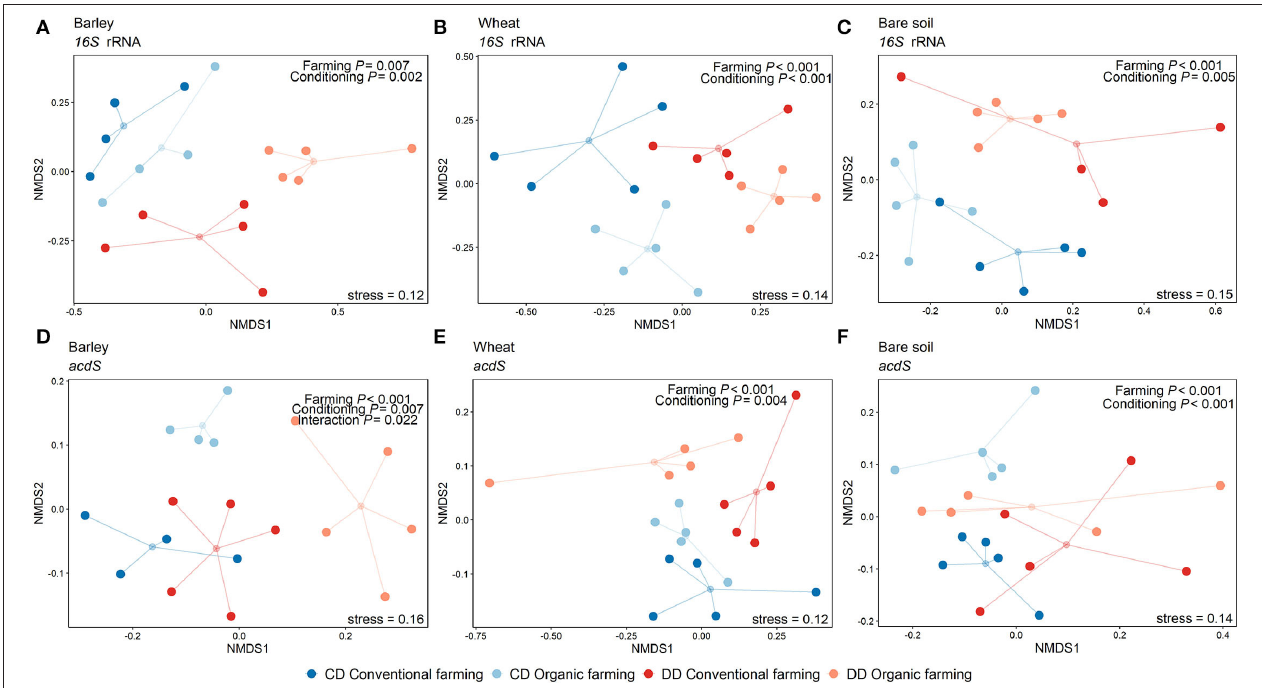
FIGURE 4 | Non-metric multidimensional scaling showing the effects of the farming system and watering during the conditioning phase per plant treatment. NMDS was performed on Amplicon Sequence Variants (ASV) using the Bray-Curtis dissimilarity matrix. The small circles correspond to the geometric center (centroid) of each treatment, and the lines indicate the distance of the samples to the centroid. Data from the 16S rRNA gene-based analysis are shown in subfigures a-c and acdS gene analyses are presented in subfigures d-f, for barley (A,D) , wheat (B,E) , and the pots without plants (C,F) . Results of the PERMANOVA are indicated in each plot ( n = 5 pots). CF: conventional farming, OF: organic farming, CD: “single water deficit,” control and dry conditions, DD: “water deficit history,” dry conditions and dry